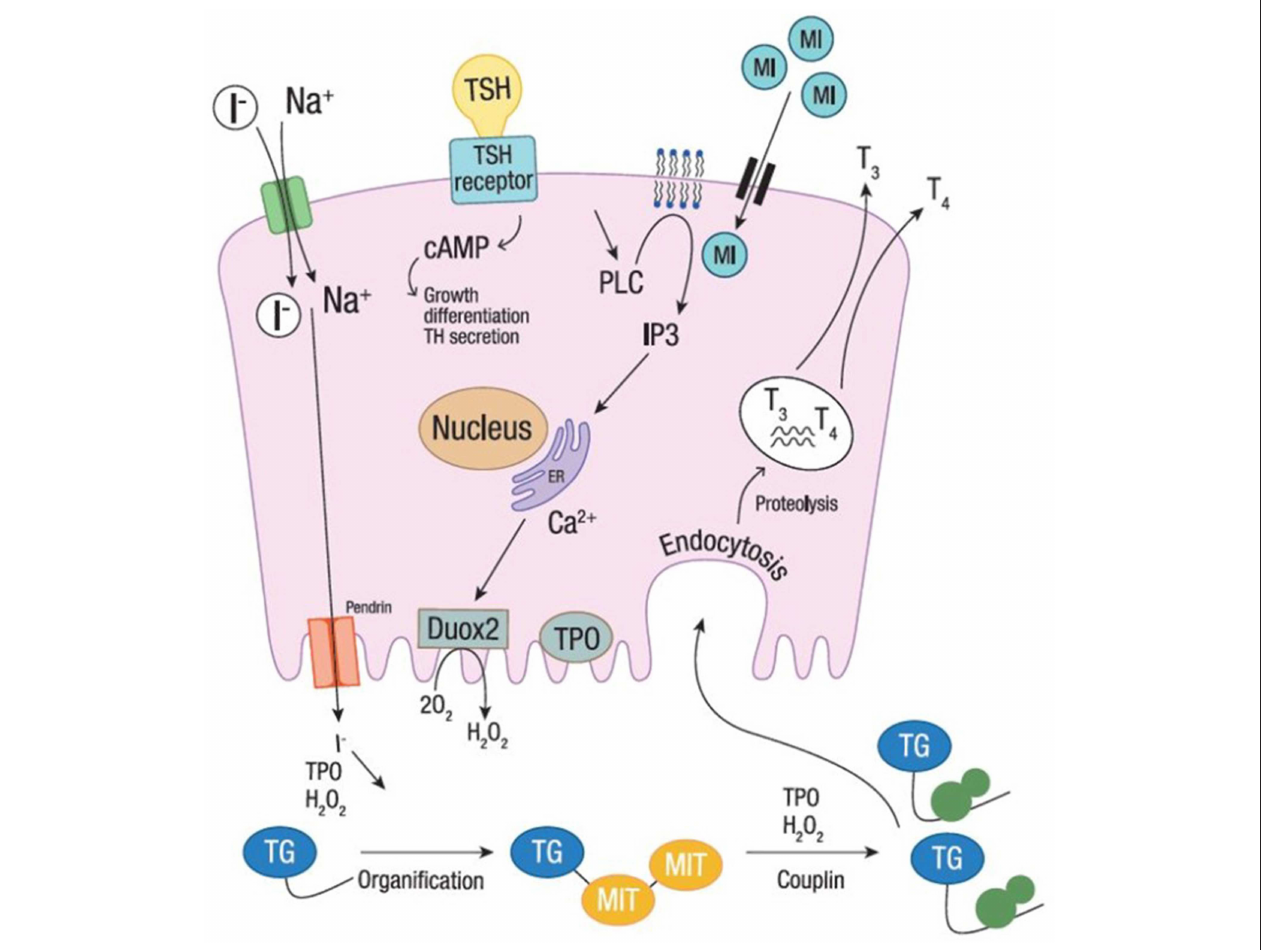
FIGURE 1 | Iodine organification. Iodine organification into thyroid follicular cells. Iodide uptake is mediated by the sodium-iodide symporter, through the gradient generated by Na + . TPO, using H 2 O 2 produced by DUOX2 system, mediates the oxidation, organification and coupling. The secretion of thyroid hormones is shown at the basolateral membrane. Myo-inositol regulates H 2 O 2 -mediated iodination through the phospholipase C-dependent inositol phosphate Ca 2 + /diacylglycerol pathway, resulting in a boost of H 2 O 2 generation. The cAMP cascade, induced by the TSH activity (through the TSH receptor activation), is also shown. I − , Iodine; MI, Myo-inositol; TSH, thyroid stimulating hormone; T 3, triiodothyronine; T 4, thyroxine; TPO, thyroid peroxidase; Tg, thyroglobulin; H 2 O 2, hydrogen peroxide; MIT, monoiodotyrosine; TH, thyroid hormone.